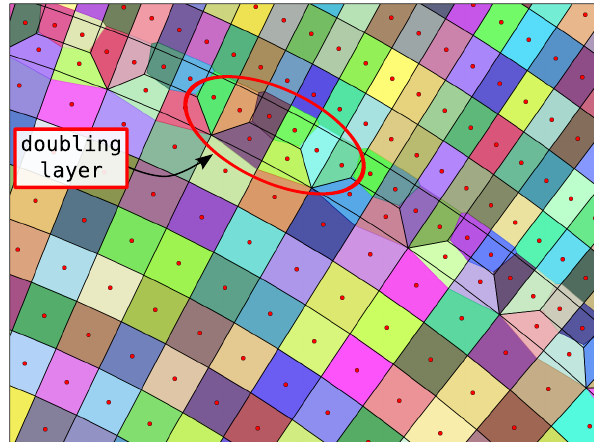
Figure 7. Voronoi approximation (colored) of the AxiSEM mesh (black lines) using the midpoints of the elements (red circles) only, zoomed onto a doubling layer for a 50s mesh. For most elements, the Voronoi cell coincides almost exactly with the AxiSEM element, note that most of the AxiSEM elements have edges of concentric circles while the edges of the Voronoi cells are all straight lines. In the worst case, six AxiSEM elements have to be tested whether a point is inside or